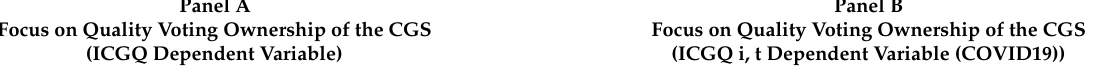
Table 7. The influence of concentration of ownership on quality voting of the corporate governance